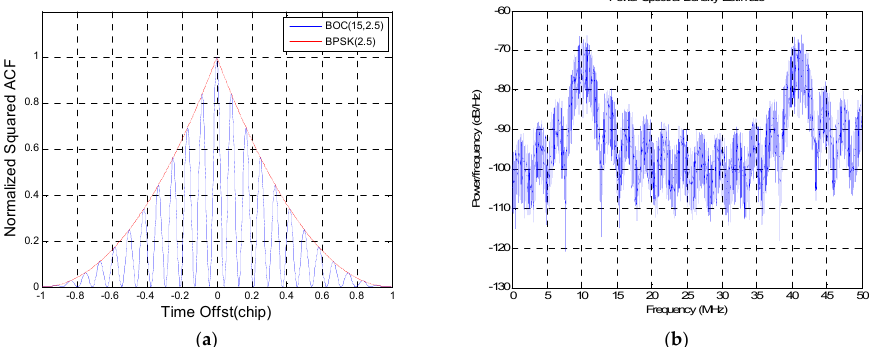
Figure 1. The normalized squared ACF and power spectrum density. ( a ) Squared ACFs; ( b ) Power spectrum density of BOC(15,2.5).